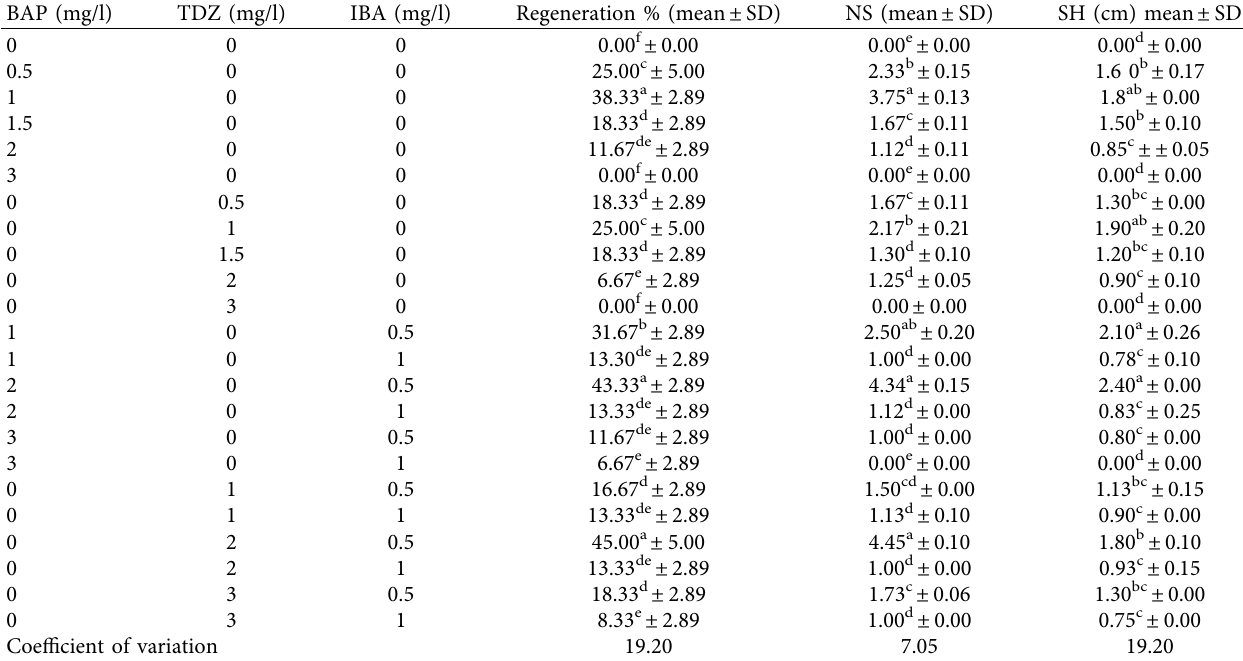
Table 6: Effect of BAP, TDZ, BAP ∗ IBA, and TDZ ∗ IBA on in vitro regeneration of korarima.